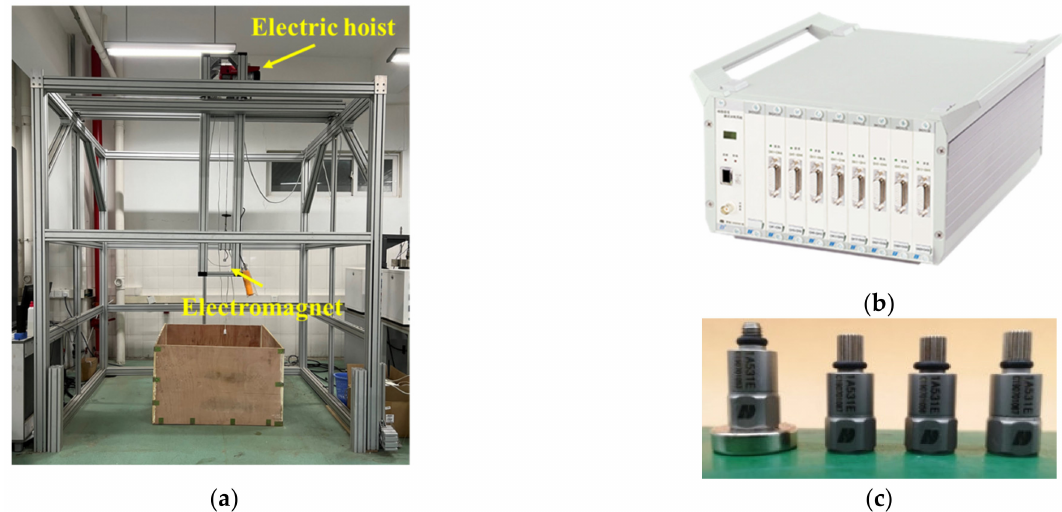
Figure 1. Experimental device. ( a ) Impact system, ( b ) dynamic signal acquisition instrument, and ( c ) IEPE piezoelectric acceleration sensor.